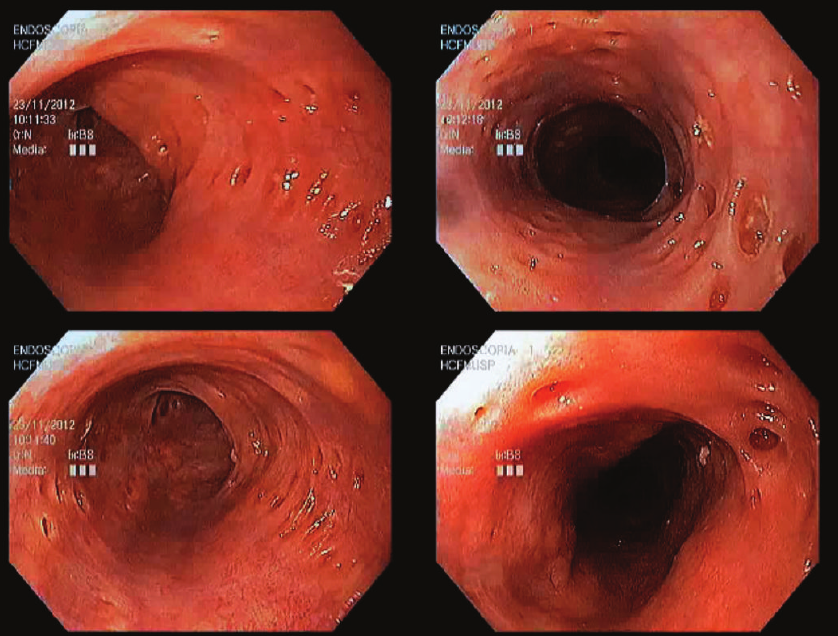
Figure 1: Endoscopic view of esophageal intramural pseudodiverticulosis revealing several small orifices, measuring between 2 and 4mm in diameter.